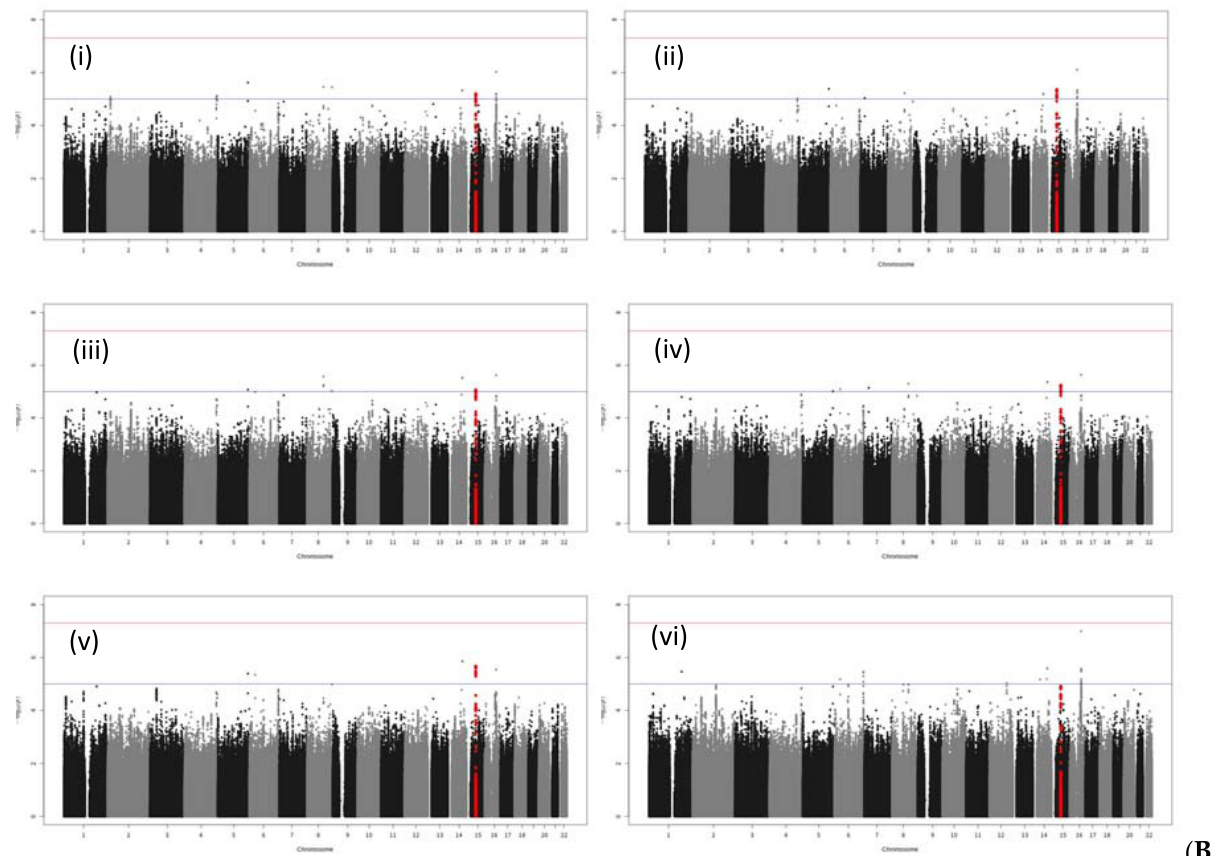
Figure 1. Manhattan plots of GWAS: ( A ) All bladder cancer; ( B ) male bladder cancer. Indus- trial/occupational factors added in GWAS: (i) 1 variable with 20 levels for industrial classification divisions; (ii) selected industrial classification divisions G and S for male bladder cancer, with divi- sions G, L, and S for all bladder cancer; (iii) 1 variable with 12 levels for occupational classification major groups; (iv) selected occupational classification major group F; (v) selected industrial classifica- tion major groups in D, E, and H, i.e., “Manufacture of general-purpose machinery”, “Miscellaneous manufacturing industries”, “Construction work by specialist contractor”, “Equipment installation work”, and “Railway transport” for male bladder cancer, and “Miscellaneous manufacturing indus- tries”, “Construction work by specialist contractor”, and “Railway transport” for all bladder cancer; and (vi) the Zaitsu classification, The SNPs in the GDLN region are plotted in red. Table 6. Results of GWAS and gene-wise analysis for bladder cancer. Results that satisfied both p < 10 − 5 by GWAS and p < 10 − 4 by gene-wise analysis were selected.